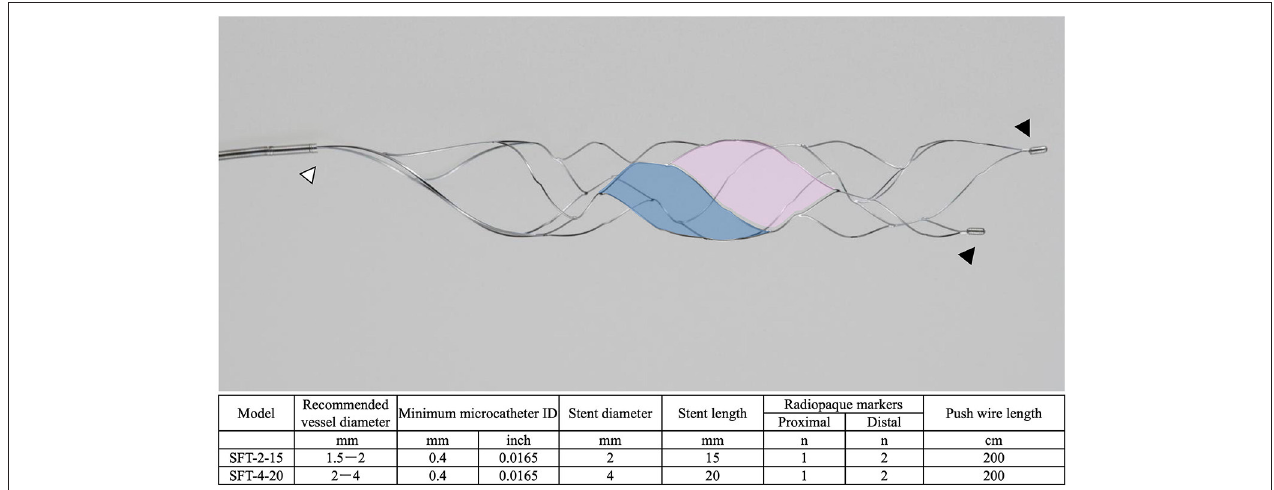
FIGURE 1 | The details of the Tron stent retriever. Photograph of the Tron stent retriever, which is constructed of two types of cells. There are a radiopaque marker in the proximal end (white arrowhead) and two markers attached to the distal end (black arrowheads). The large cell (pink) captures the thrombus, and the small cell (blue) reduces stent extension at the